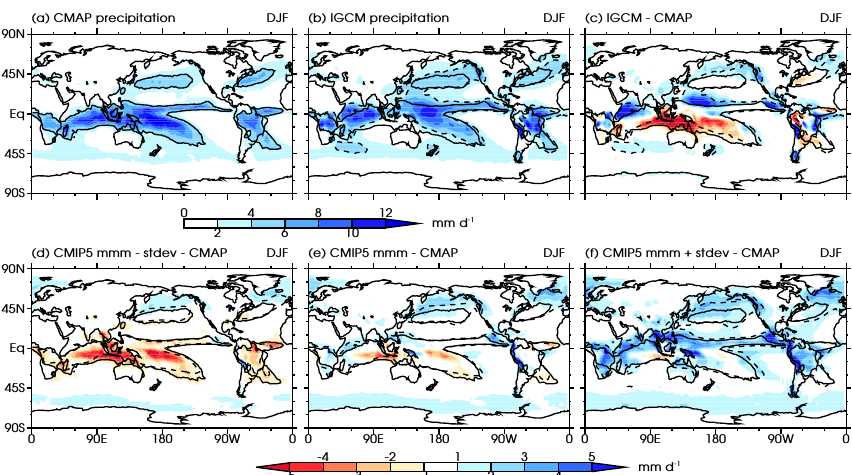
Figure 4. DJF season mean precipitation (mmday − 1 ) in CMAP (a) , IGCM4 (b) and difference between IGCM4 and CMAP (c) . (e) shows the difference between a multi-model mean of an ensemble of CMIP5 GCMs integrated using AMIP SSTs and CMAP; (f) as for (e) but for the multi-model mean minus 1 standard deviation; (g) as for (e) but for the multi-model mean plus 1 standard deviation. In all cases the solid line is the 4mmday − 1 contour in CMAP and the dashed line is the same contour in the model of the subfigure. (a, b) are based on the top colour bar, (c) – (f) are based on the bottom colour bar. The CMIP5 models used in the ensemble are ACCESS1.0, ACCESS1.3, BCC-CSM1.1, BCC-CSM1.1(m), BNU-ESM, CanCM4, CCSM4, CESM1(CAM5), CCMC-CM, CNRM-CM5, CSIRO-Mk3.6.0, FGOALS- g2, GFDL-CM3, GISS-E2-R, HadGEM2-AO, INM-CM4, IPSL-CM5A-LR, IPSL-CM5A-MR, IPSL-CM5B-LR, MIROC5, MPI-ESM-LR, MPI-ESM-MR, MRI-CGCM3 and NorESM1-M. The mean is over the years 1979–2005.